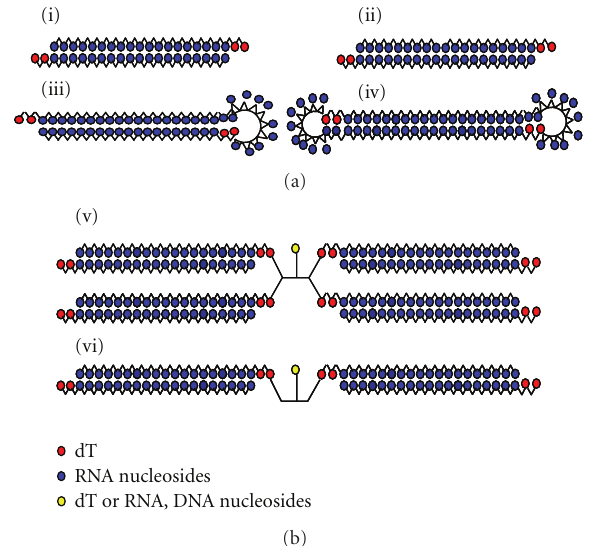
Figure 1: Duplex RNA architectures for RNA interference. (a) Described previously in the introduction: (i) canonical siRNA antiparallel duplex; (ii) small internally segmented interfering RNA (sisiRNA); (iii) small hairpin RNA (shRNA); (iv) dumbbell siRNA. (b) Branched siRNA described in thisstudy: (v) four-stranded RNA; (vi) two-stranded